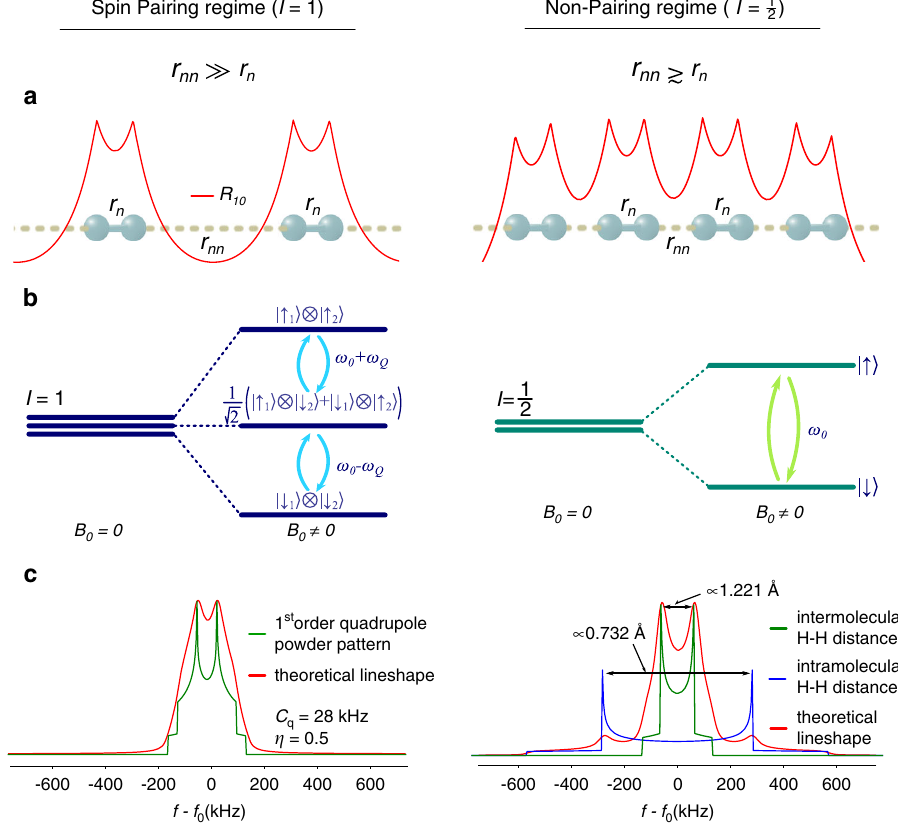
Fig. 1 Overview of both spin-pairing and non-pairing regimes. a Schematic representation of the wave function overlap (red lines) of H 2 molecules. b Schematic representation of the nuclear spin energy levels under the in fl uence of an external magnetic fi eld B 0 for the pairing (i.e. quadrupole interaction) and non-pairing (dipole – dipole interaction) regimes. c Theoretical line shapes in the pairing and non-pairing regime. ω 0 = 2 π f 0 denotes the Larmor frequency of the hydrogen nuclei, ω Q , η and C q are the quadrupole frequency, the asymmetry parameter and the quadrupole coupling constant,